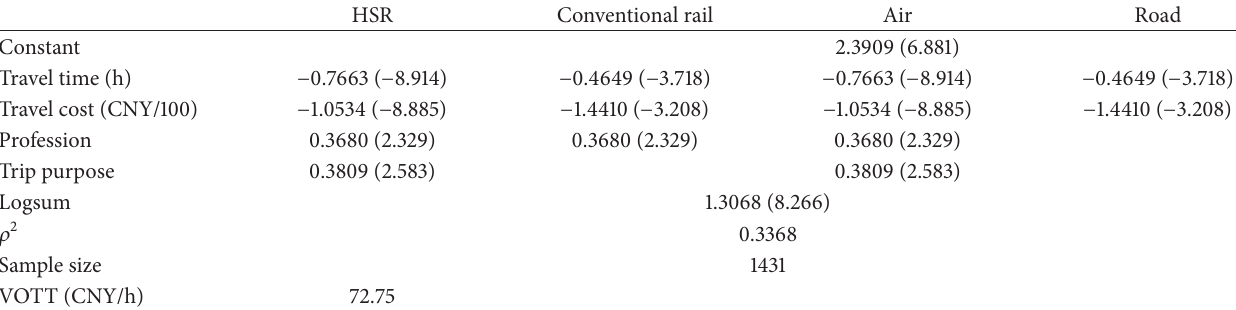
Table 4: Estimations of middle-income group ( t -statistics are in parentheses).